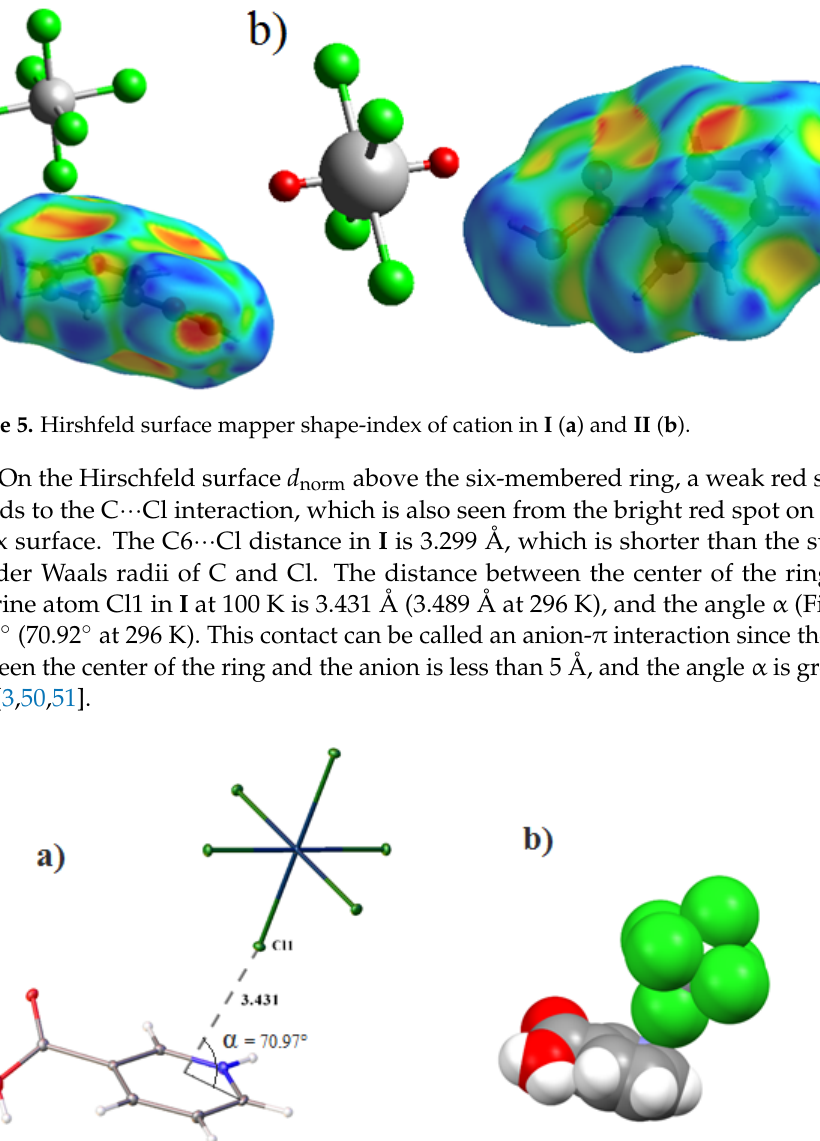
Figure 4. Hirshfeld surface mapper over d norm for ( a ) cation and ( b ) for anion to visualize the inter- actions in compound I and in II ( c ).